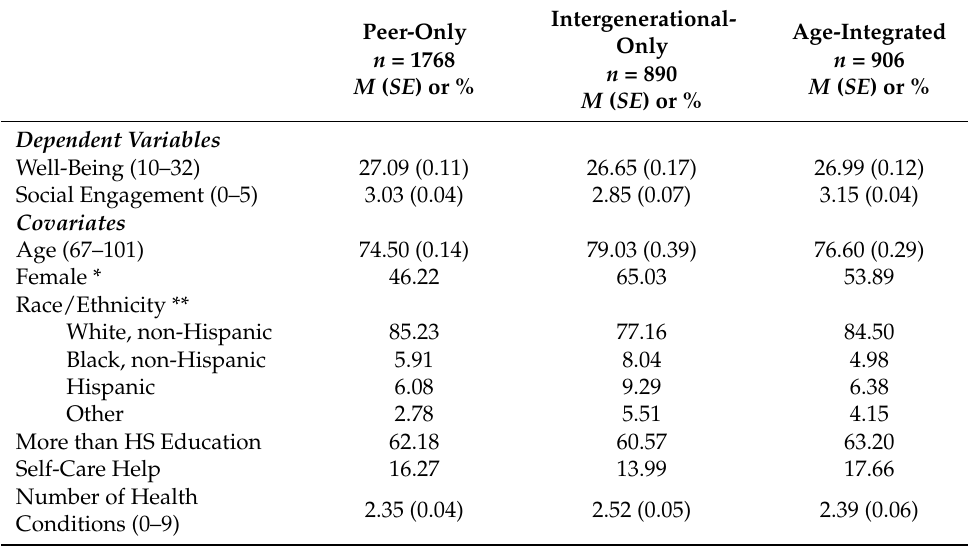
Table 2. Weighted Descriptive Statistics Stratified by Age Integration